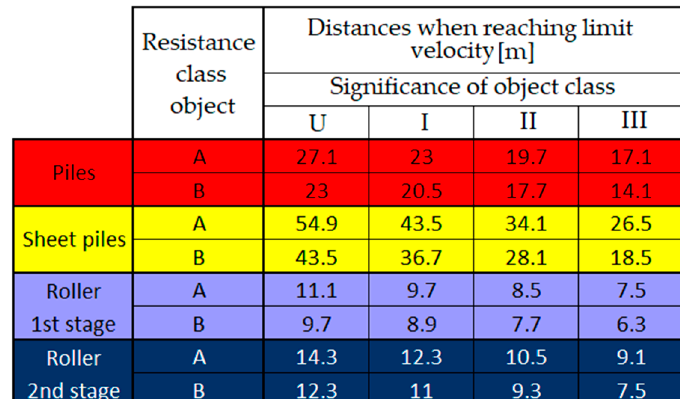
Figure 14. Calculated distances achieved in the limit particle velocity.